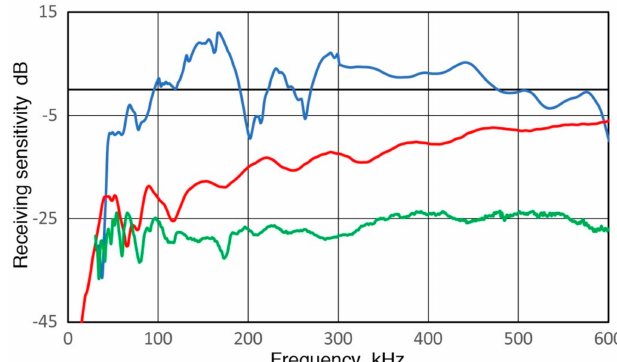
Figure 2. Receiving displacement sensitivities of PAC R15a (blue curve), Olympus V103 (red) and KRN BB-PCP (green). Sensitivity in dB in reference to 1 V/nm. Input impedance = 10 k Ω